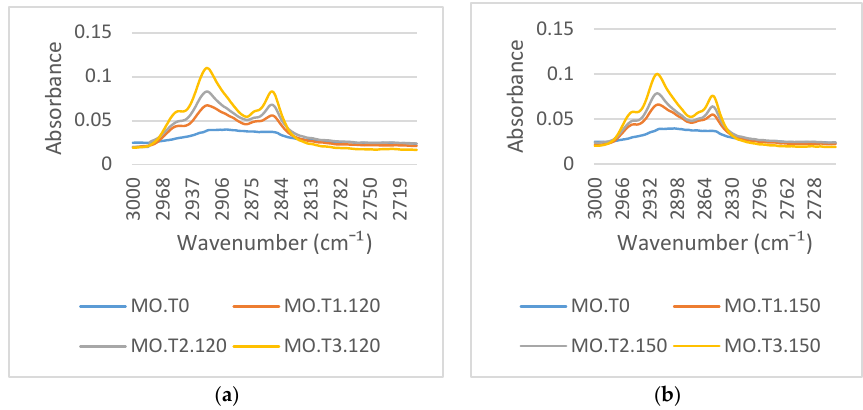
Figure 6. FTIR spectra at 3000–2700 cm − 1 of transformer paper aged in mineral oil at aging temperatures of ( a ) 120 °C and (b ) 150 °C.